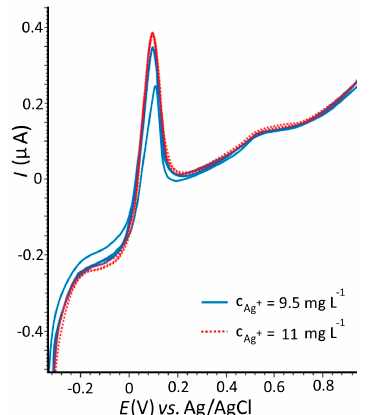
Figure 1. Current–voltage curves of Ag(I). Conditions of experiments: medium of 1 mol L − 1 HCl + NH 4 OH, E e = − 0.7 V; τ e =120 s; v = 0.06 V s − 1